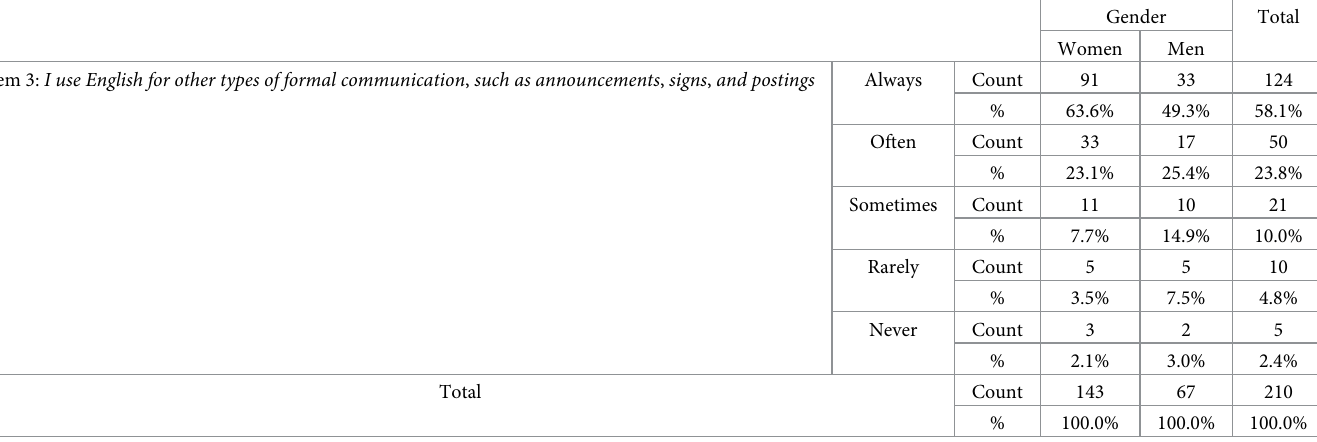
Table 5. English use for other types of formal